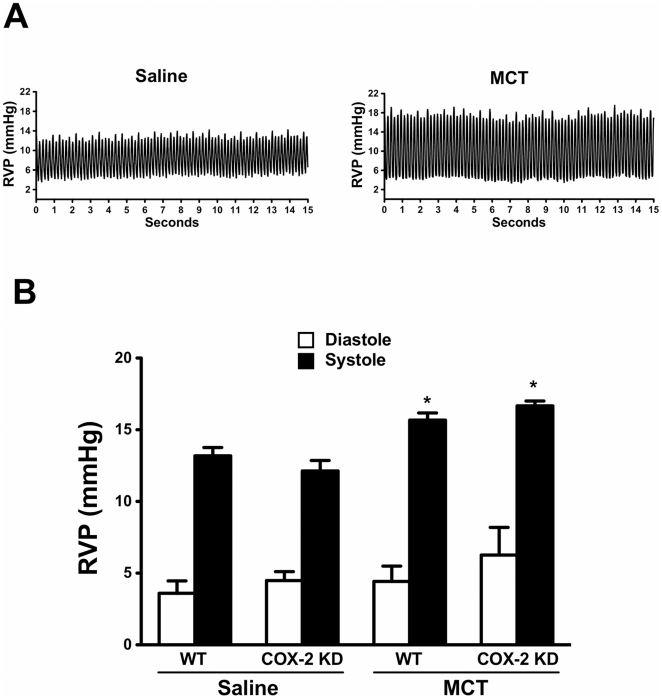
Monocrotaline-induced pulmonary arterial hypertension in mice.A. Representative right ventricular pressure (RVP) tracings recorded after 10 wk of monocrotaline (MCT) or saline administration, by inserting a pressure transducer directly into the right ventricle. B. Right ventricular pressures (RVP) were calculated from tracings as in panel A, by averaging 15 s intervals of continuous recording. WT/saline, n = 6; WT/MCT, n = 5; COX-2 KD/saline, n = 5; COX-2 KD/MCT, n = 3. mmHg, millimeters of mercury. *, p<0.05 vs saline.